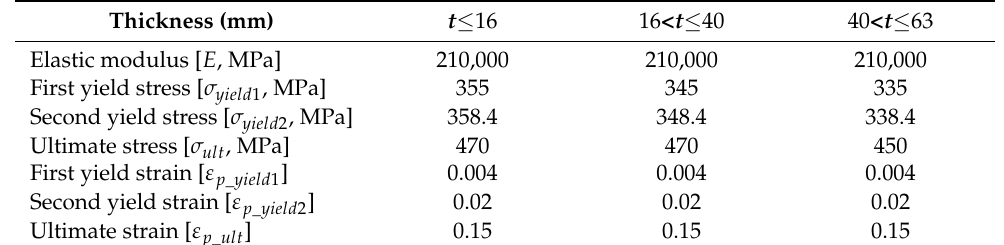
Table 3. Material properties for S355 [30].